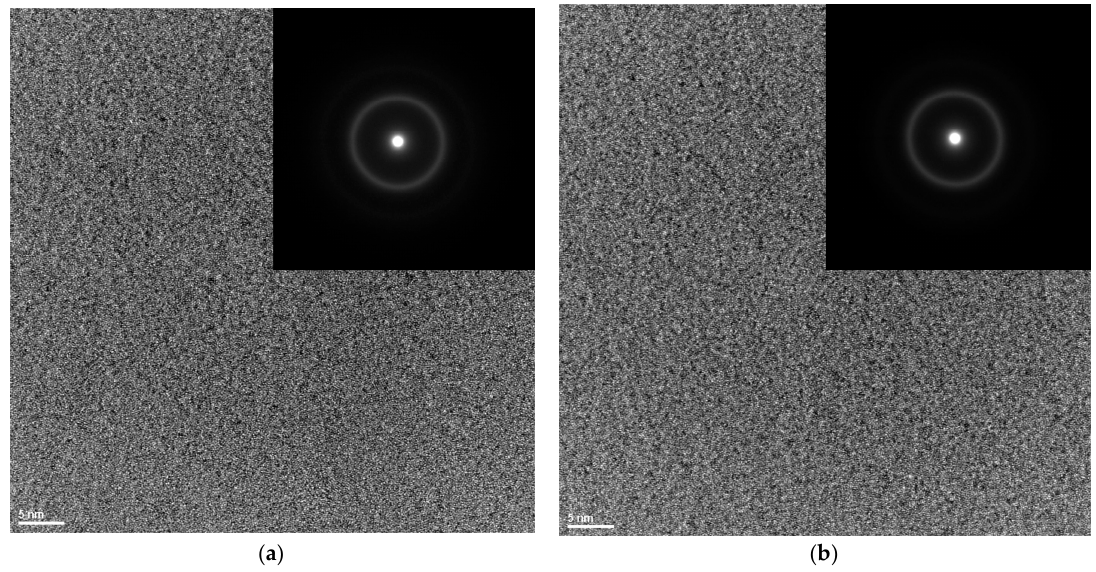
Figure 3. High-resolution transmission electron microscopy (HRTEM) images and the selected area electron diffractions (SAED) of ( a ) Fe 36.00 Co 36.00 B 19.00 Si 5 Nb 4 and ( b ) Fe 35.75 Co 35.75 B 18.90 Si 5 Nb 4 Cu 0.6 amorphous alloys in ribbon form with the thickness of 0.07 mm. Materials 2017 , 10 , 625